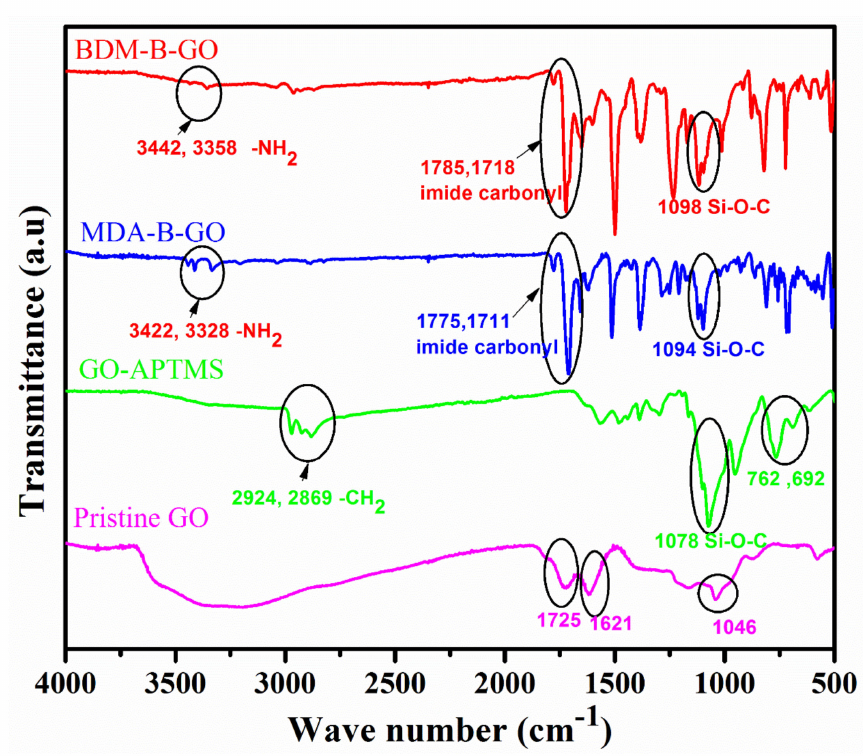
Figure 1. FTIR spectra of GO, GO-APTMS, MDA-B-GO and BDM-B-GO.